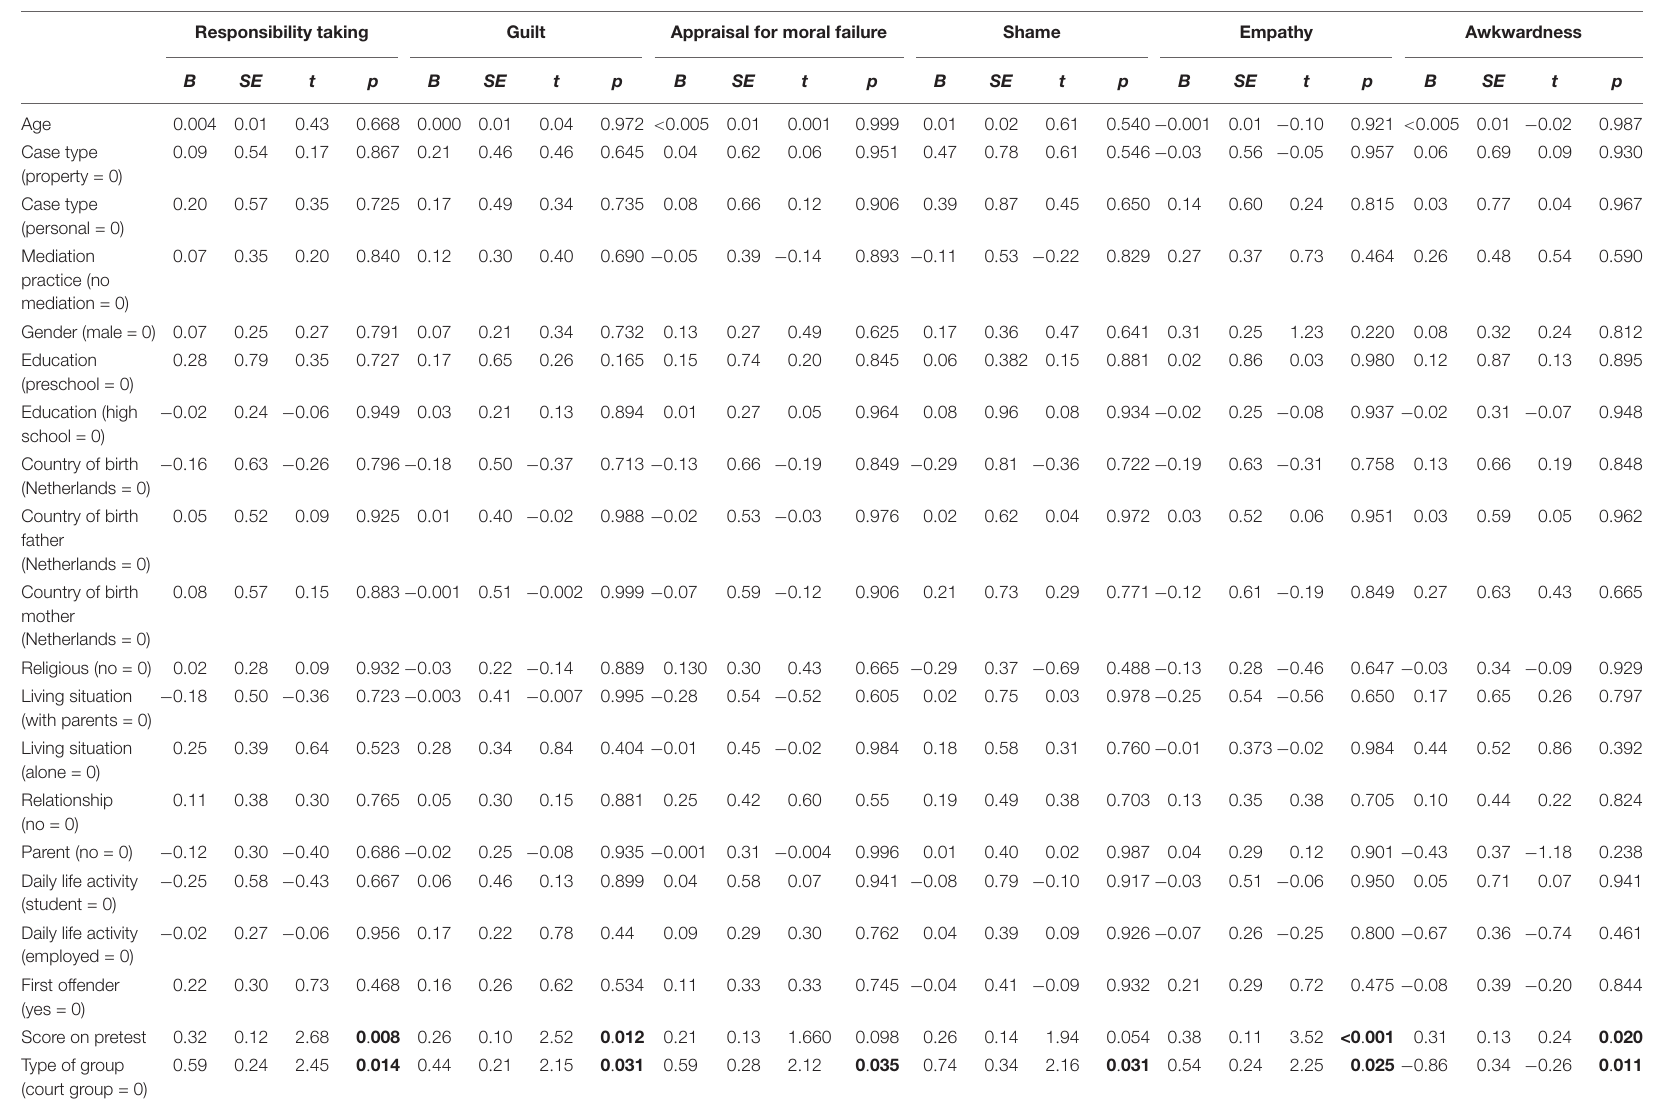
N = 86. Significant outcomes are given in